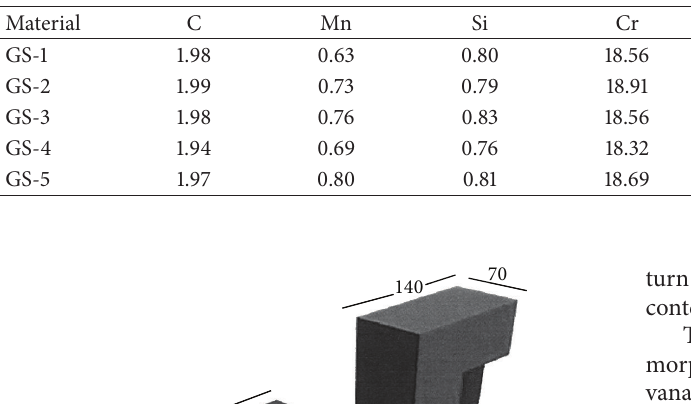
Table 1: Chemical analysis of the steel patches.